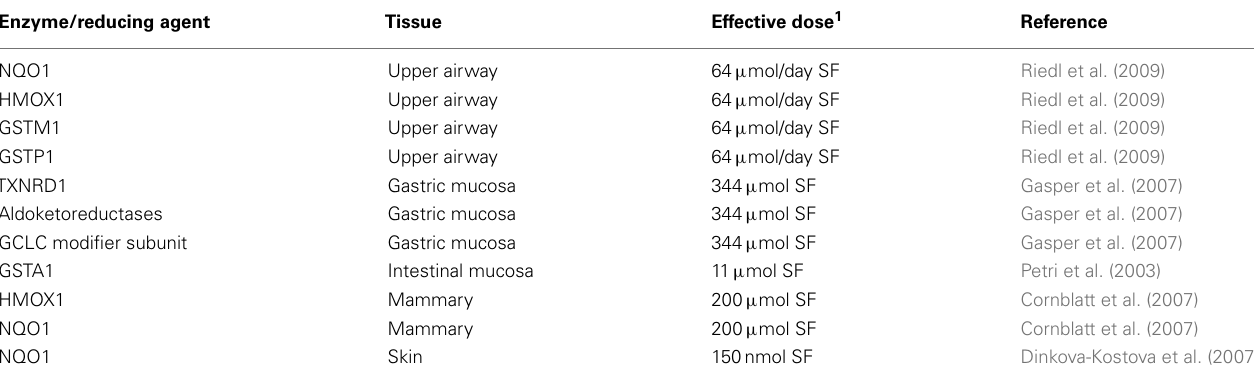
Table 1 | Summary of human clinical evidence for induction ofARE-mediated enzymes by sulforaphane/ITC. Enzyme/reducing